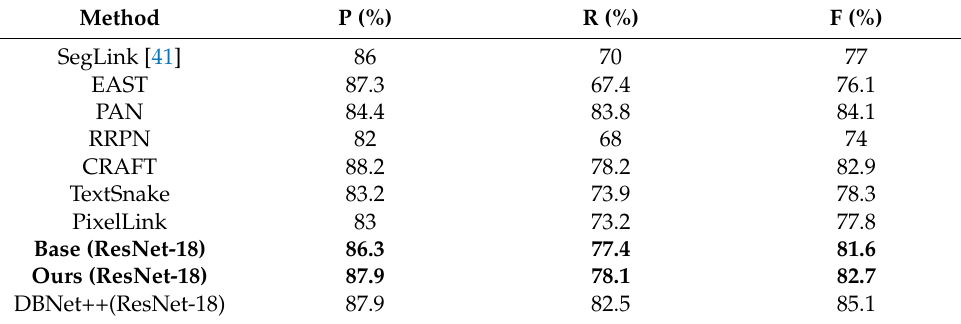
Table 3. Detection results on the MSRA-TD500 dataset.